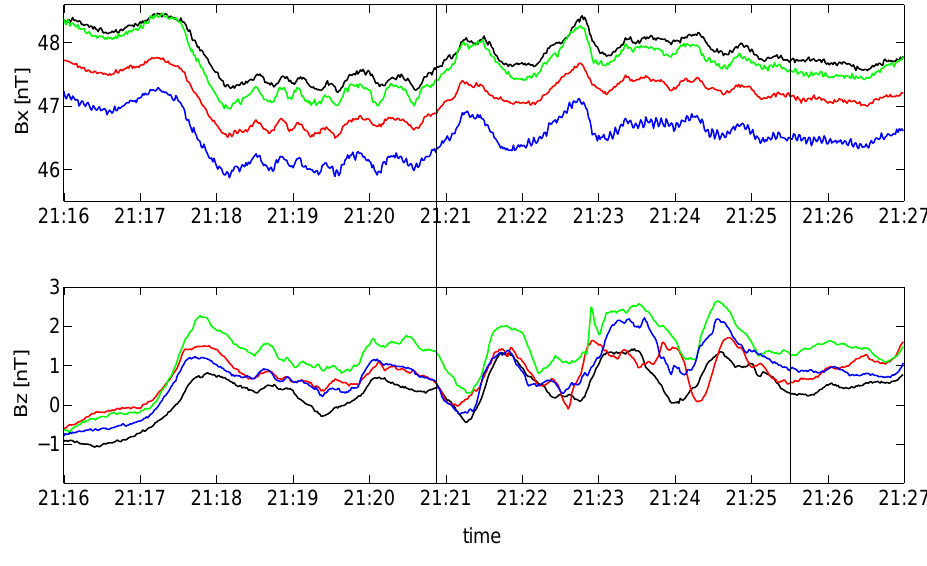
Fig. 3. Composite reconnection event on 8 September 2002 observed by Cluster. The interval chosen for reconstruction is marked by the vertical